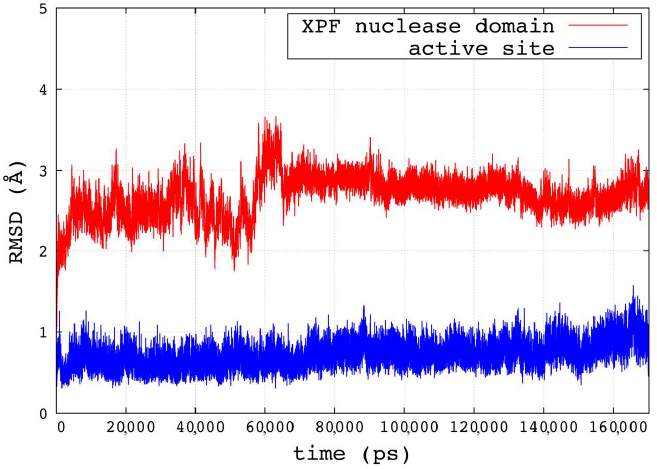
Figure 2. Root-mean-square deviation (RMSD) trends for the backbone atoms of the human XPF nuclease domain (red) and the active site (blue), defined as residues D687, R689, E690, D715, E725, R726, K727, and D731.